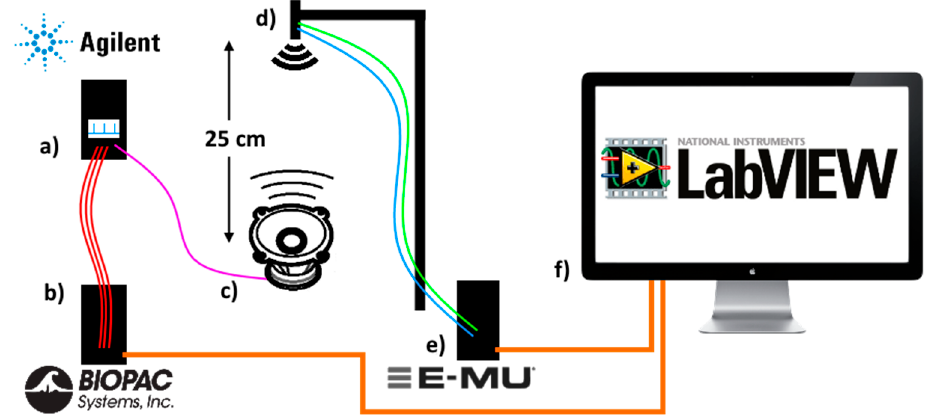
Figure 3. Test signal experiment consisting of ( a ) Agilent signal generator, generating a pulse signal with 0.5% duty cycle. The generated signal was connected to ( b ) Biopac ECG commercially available III-lead ECG system and ( c ) a standard speaker. The membrane of the speaker vibrated with the selected frequency (0.75 Hz to 3.6 Hz), mimicking a human torso. At the distance of 25 cm; ( d ) US transducers recorder the speaker signal via the ( e ) E-MU 24-bit/192 kHz A/D converter. Both acquired signals were analyzed by the ( f ) LabVIEW software.